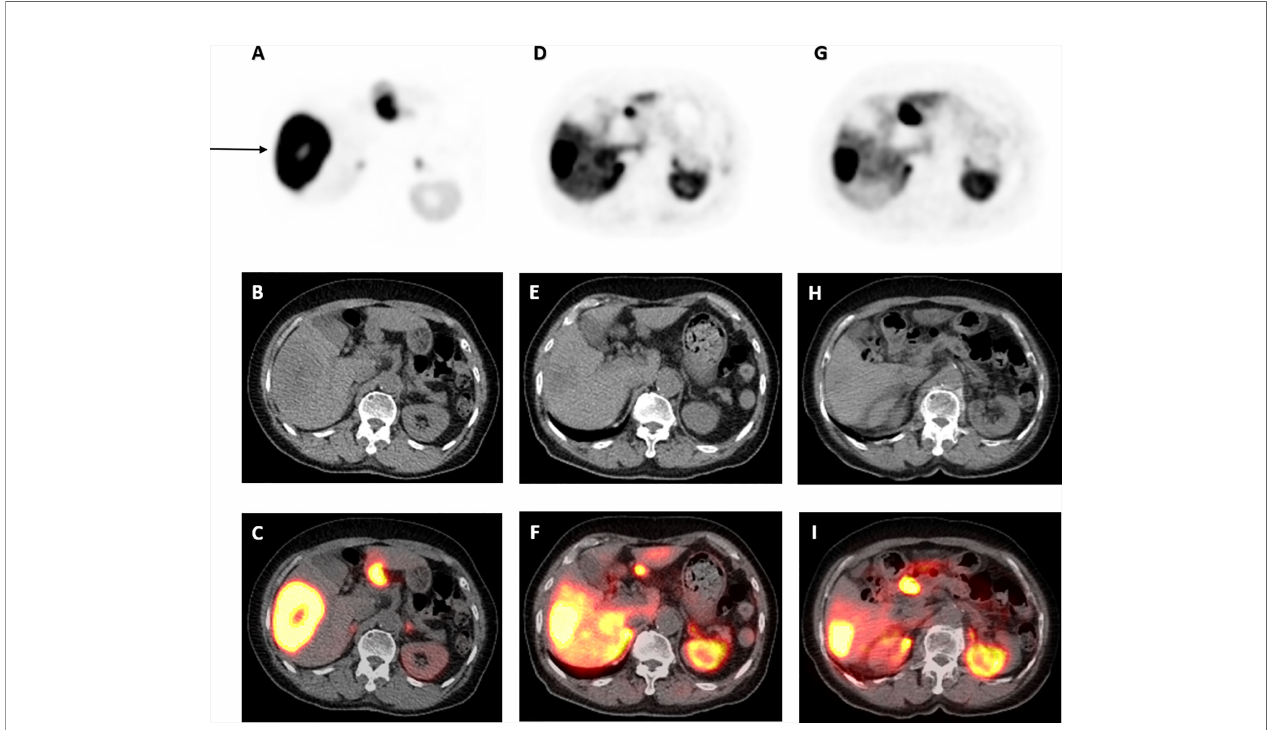
FIGURE 2 | 68Ga-DOTATATE PET/CT scan images of dominant right liver lobe lesion pre- and post-177 Lu-DOTATATE. Axial view images of 68 Ga-DOTATATE PET/CT scan demonstrating interval reduction in size in dominant right liver lobe lesion (arrow) on PET, low-dose CT and PET/CT fusion (top to bottom) from baseline, to 1 and 4 years after 177 Lu-DOTATATE therapy (left to right). Physiological uptake in the spleen and remainder of the liver is also